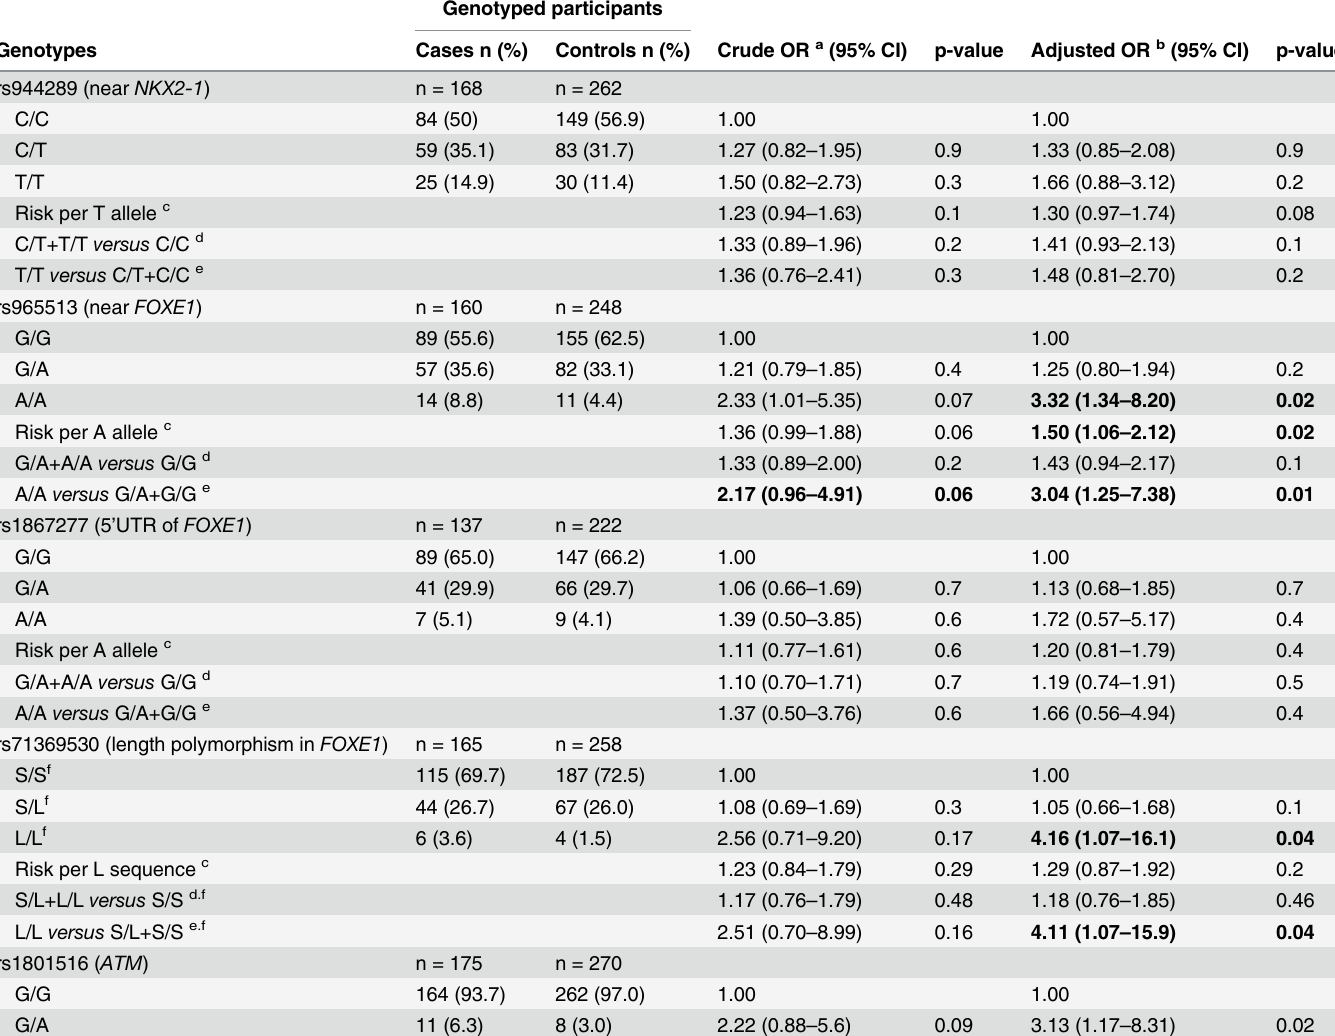
Table 2. Association results between the five polymorphisms and the risk of developing